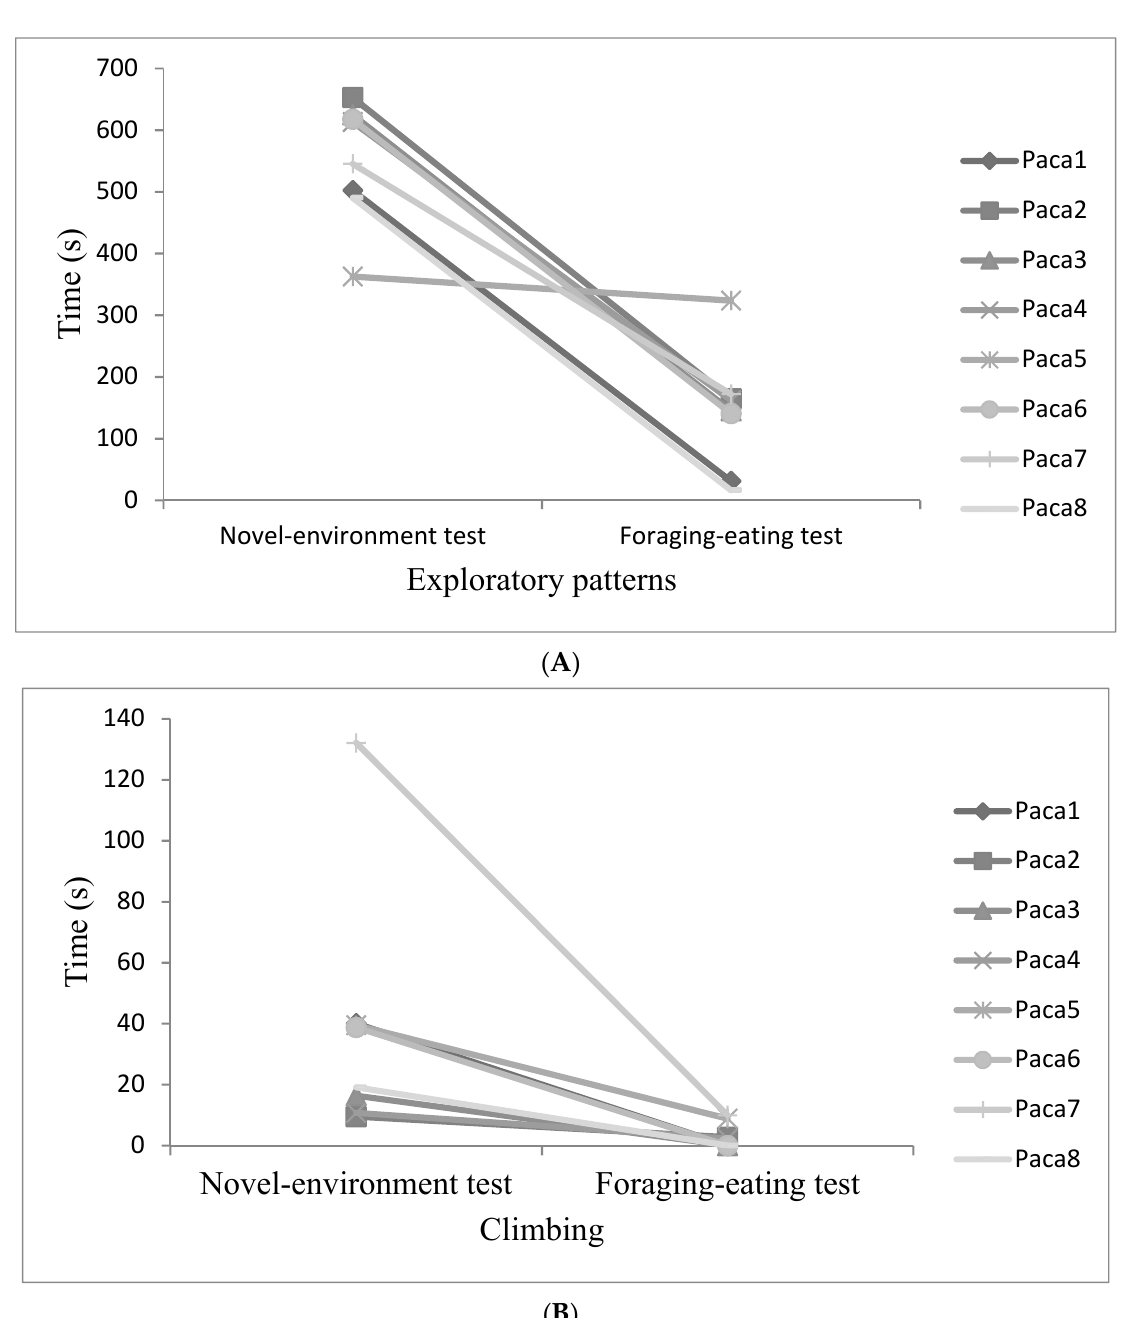
Figure 4. Time pacas ( n = 8) spent on the exploratory behavioural patterns (roaming, sniffing, and raising forelegs) ( A ) and climbing pattern ( B ) during novel-environment and foraging–eating